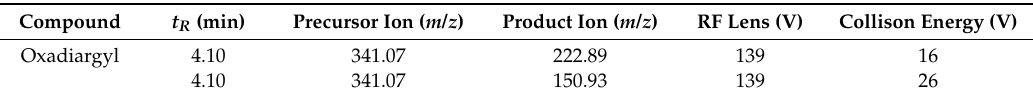
Table 2. High-performance liquid chromatography (HPL—Ctandem mass spectrometry (MS/MS) detection parameters for